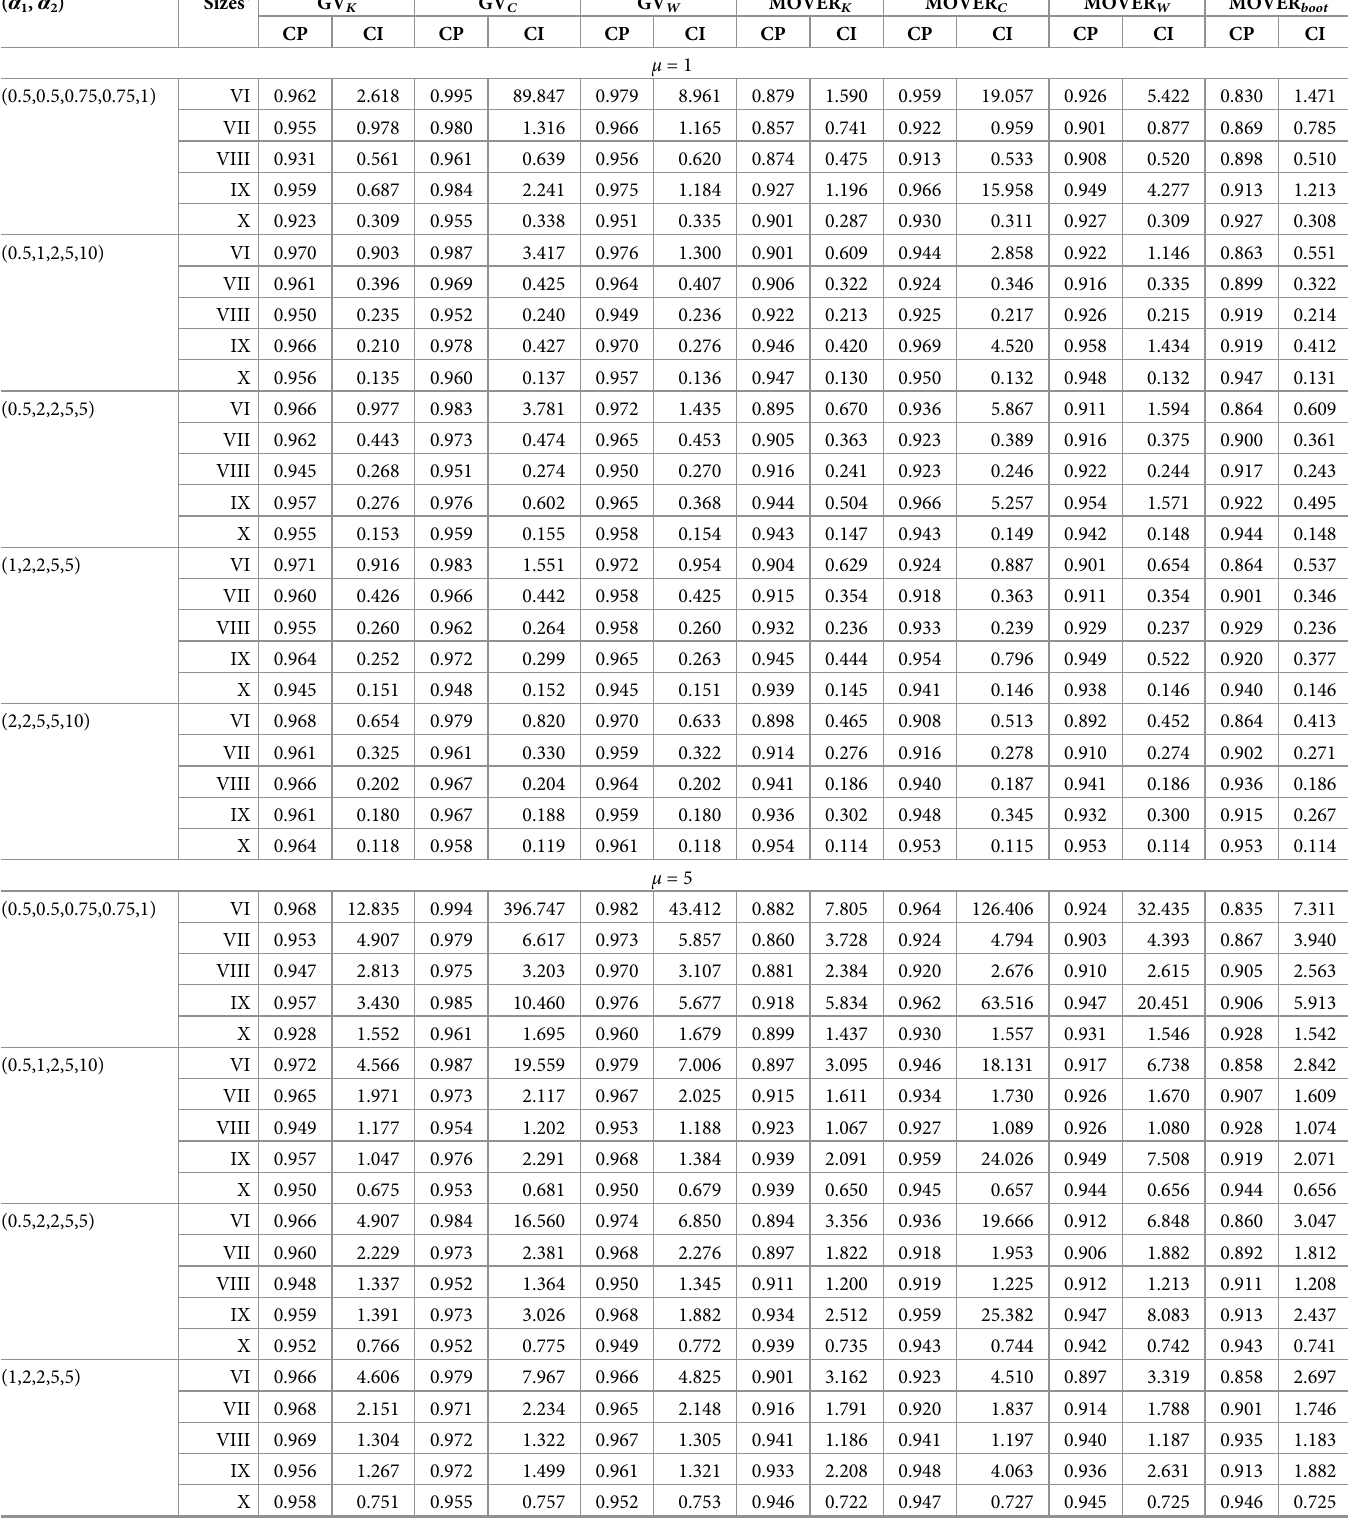
Table 2. Coverage probabilities (CP) and length of confidence interval (CI) of proposed 95% confidence intervals for the common gamma mean (2000 simulations) with two independent samples ( K = 5). ( α 1 , α 2